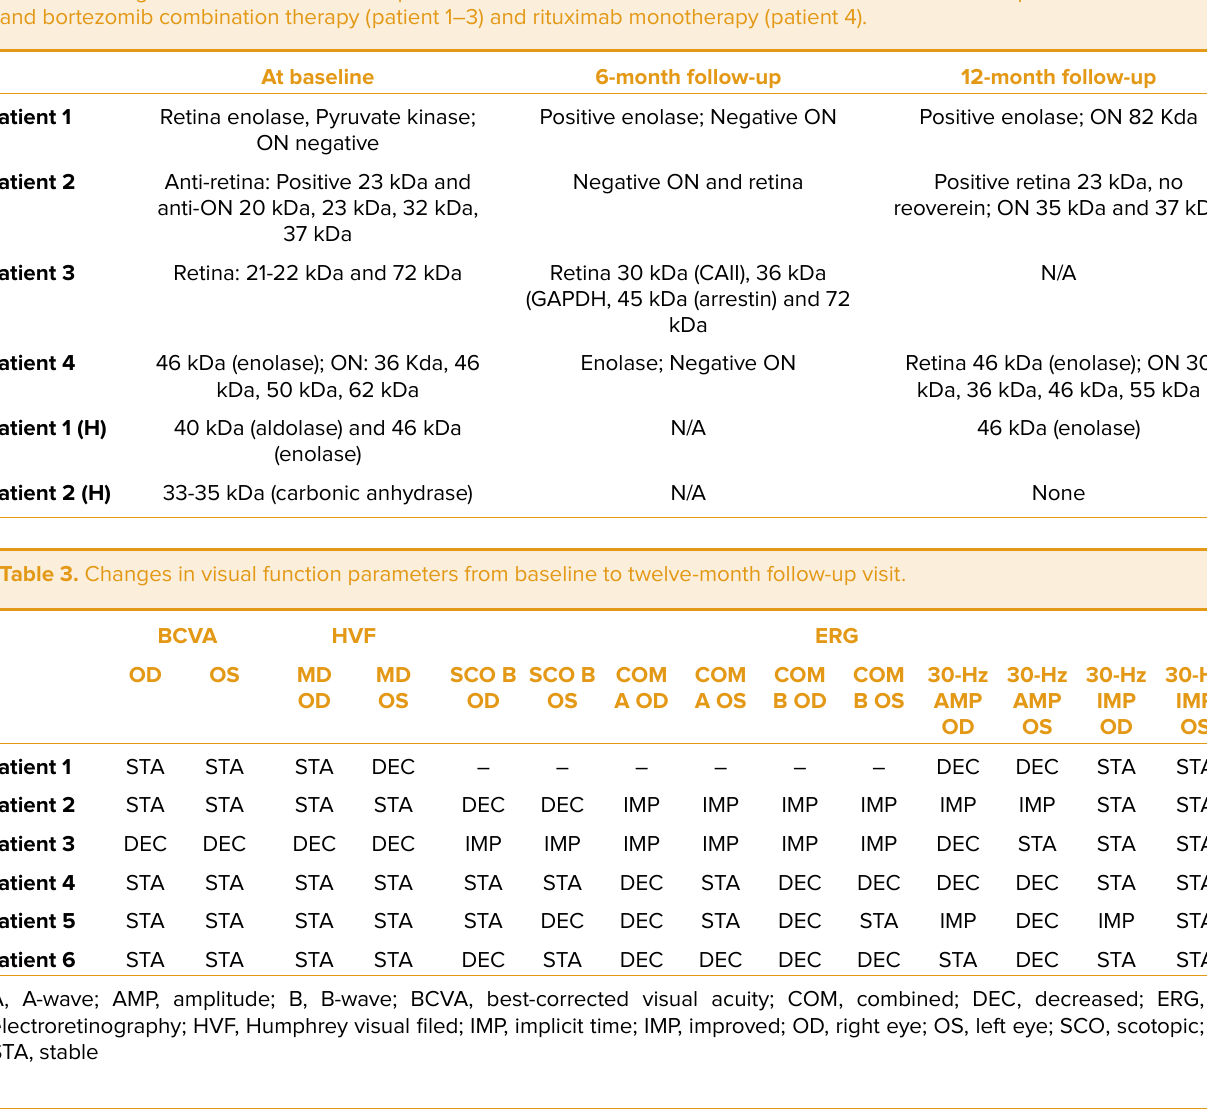
Table 4. Response of visual function parameters to rituximab and bortezomib combination therapy versus rituximab